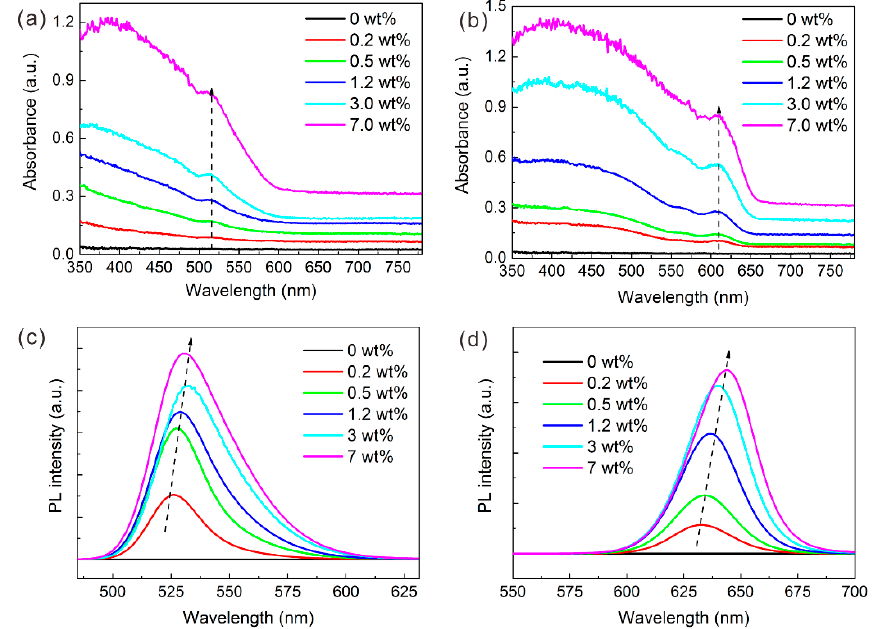
Figure 4. Absorption spectrum of ( a ) GQD and ( b ) RQD film; photoluminescence (PL) spectrum of ( c ) GQDs and ( d ) RQD film.